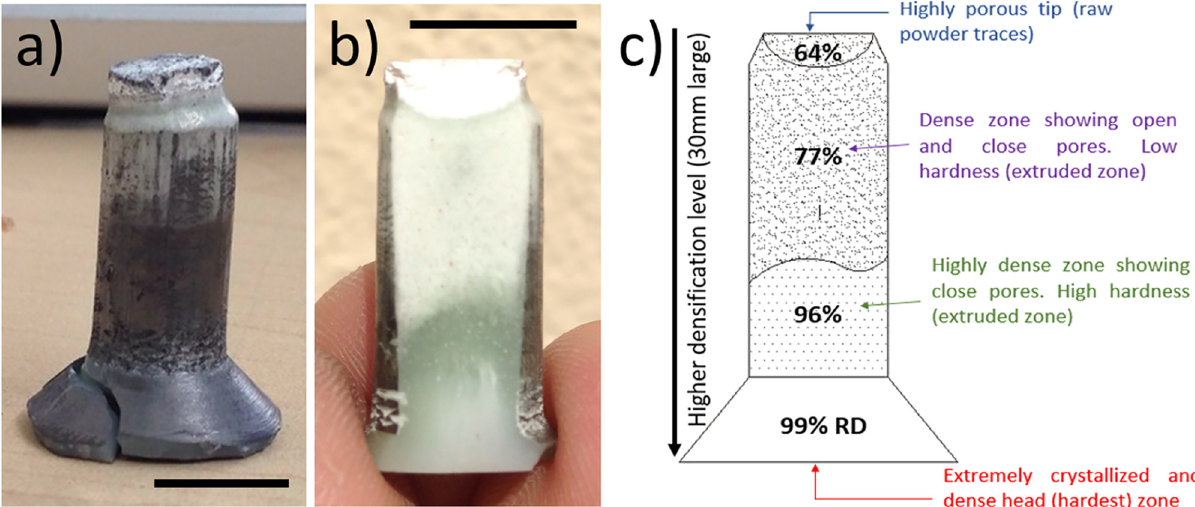
Figure 6: Physical aspect of the HA extrudates obtained by SPE: ( a ) representative image of an extruded sample showing a fracture at the head generated upon its release from die, ( b ) the same specimen after polishing demonstrating the variety of colors developed due to the di ff erent densi fi cation levels attained. The samples were white - bright at the tip ( highly porous ) and translucent at the head ( high dense ) . ( c ) Sketch with the RD attained at di ff erent zones of the monolith. The scale bars in ( a ) and ( b ) correspond to 10